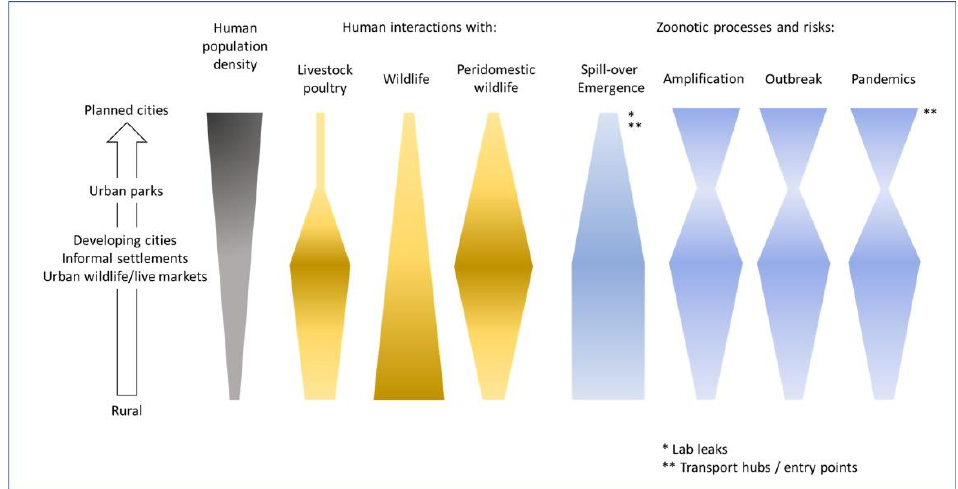
Figure 2: Graphical summary of the main hypothetical trends in terms of animal-human interaction and zoonotic processes that we believe are expected along a rural-urban